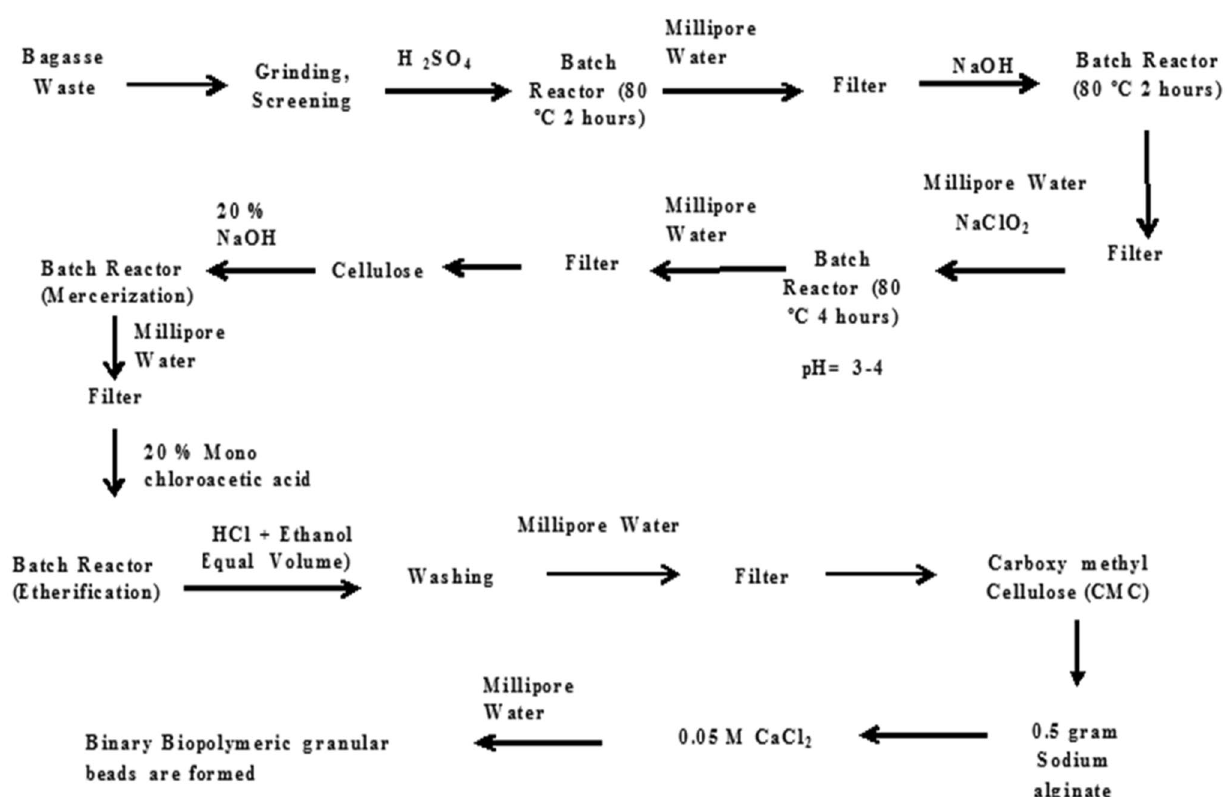
Fig. 1 Preparation of bio-polymeric beads from laboratory-made